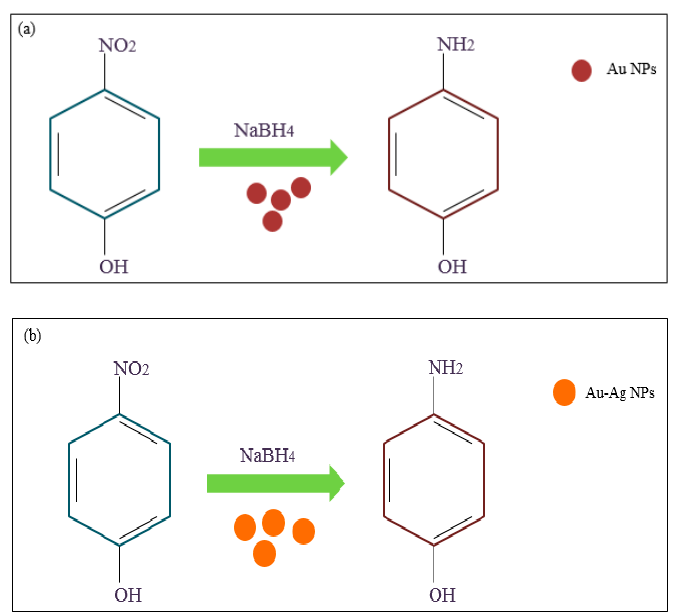
Figure 7. Schematic illustration of the catalytic experiments of 4-NP with ( a ) Au NPs and ( b ) Au-Ag NPs.